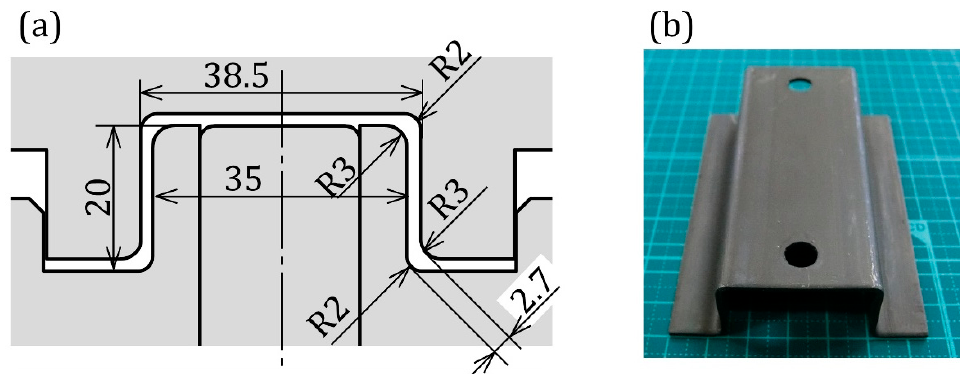
Figure 4. ( a ) Dimensions of dies for hot hat-shaped bending using planar compression and ( b ) hot- stamped part.